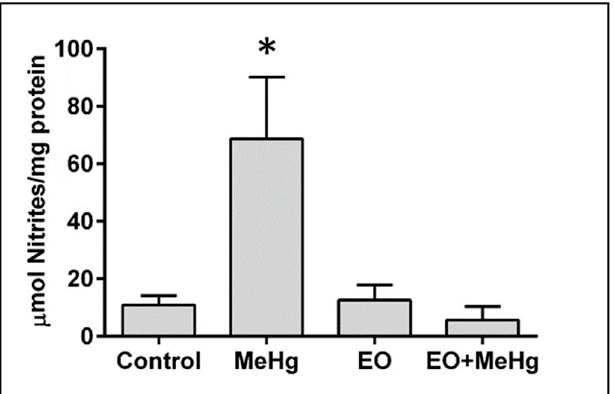
Figure 6. Euterpe oleracea protects against methylmercury-induced nitrites production. Mice were treated with clarified E. oleracea juice (EO) once a day for 8 days and/or methylmercury (MeHg) for 4 days. Data are presented as mean ± SEM ( n = 6–8). * p < 0.05 vs all groups.